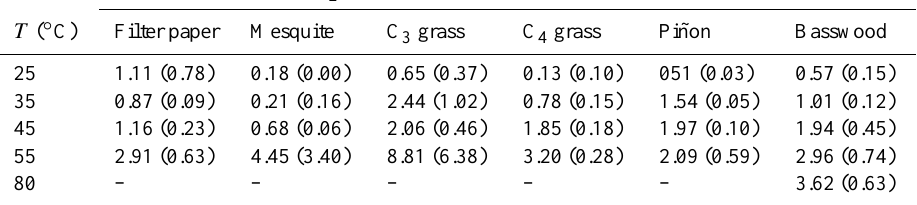
Table 2. Mean (standard error: SE) molar ratios between H 2 production rate during thermal degradation and photodegradation of six plant litter types ( n = 3). Only the lignin proxy (wood sheets of basswood) was used for the 80 ◦ C